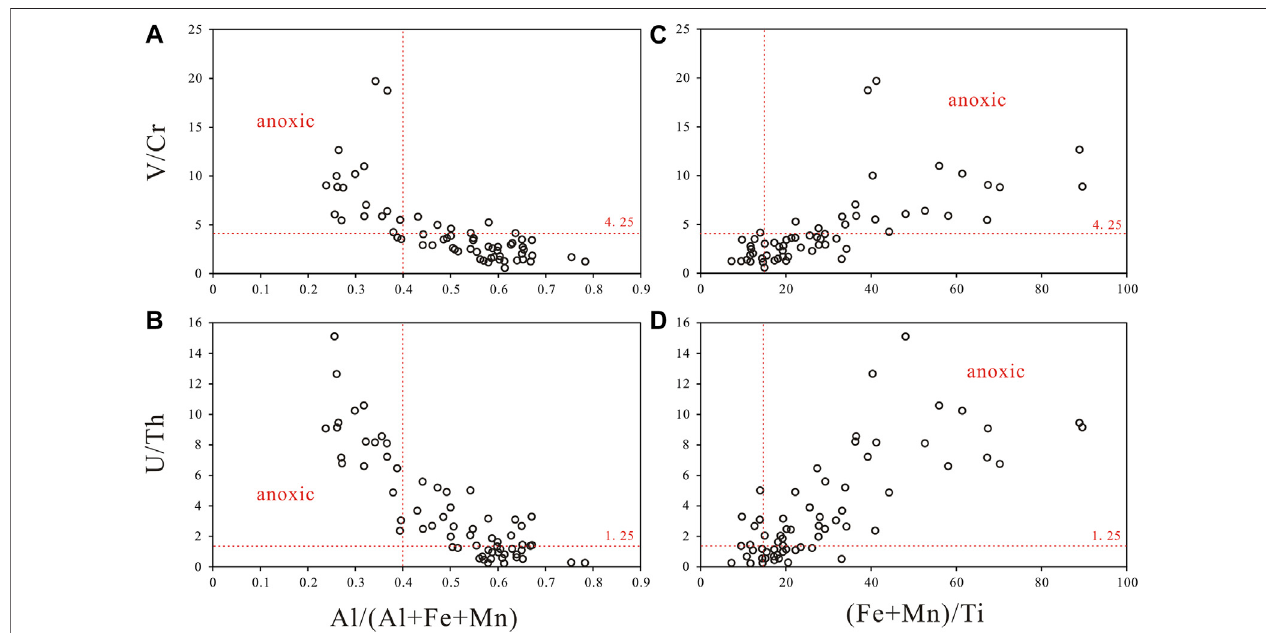
FIGURE 10 | Crossplots of V/Cr and U/Th vs. Al/(Al + Fe + Mn) and (Fe + Mn)/Ti of the Chang 7 black shale in the Ordos Basin. The threshold values of anoxic are from Jones and Manning (1994).